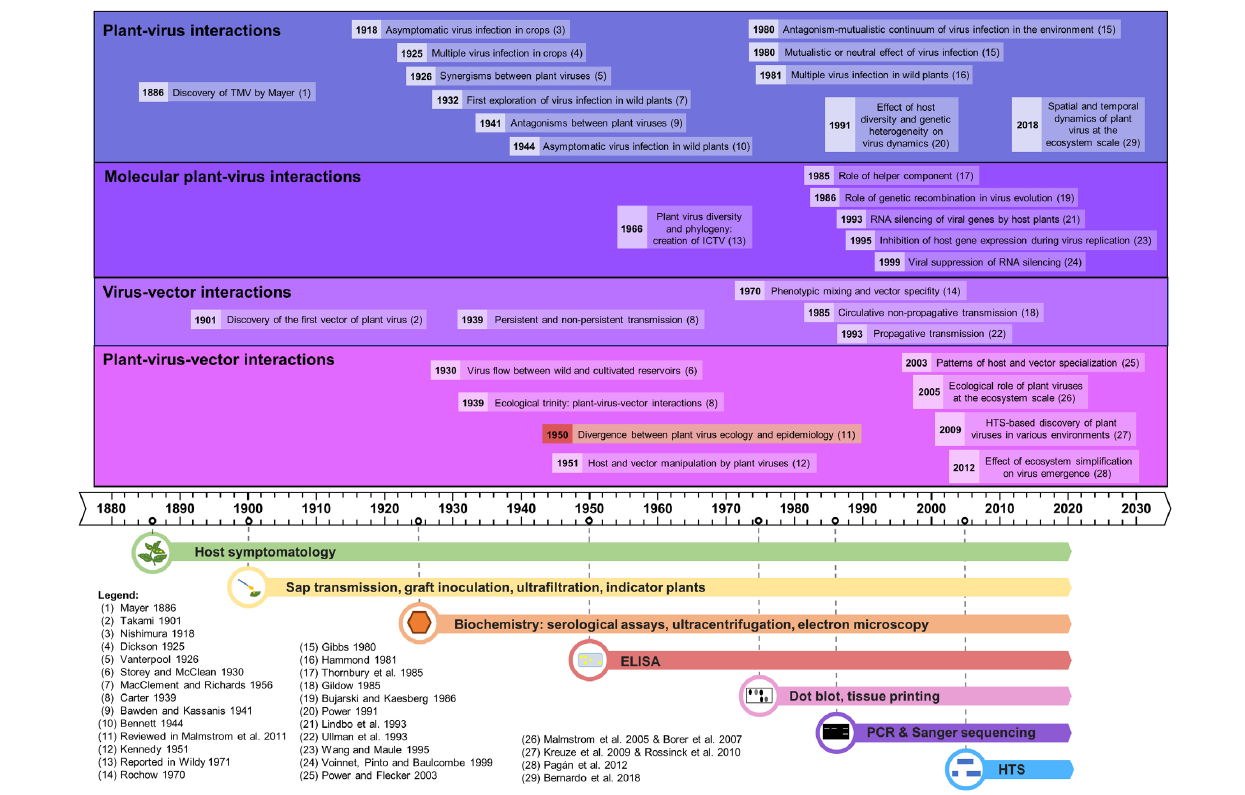
(ELISA), and radioactivity (dot blots, tissue printings,